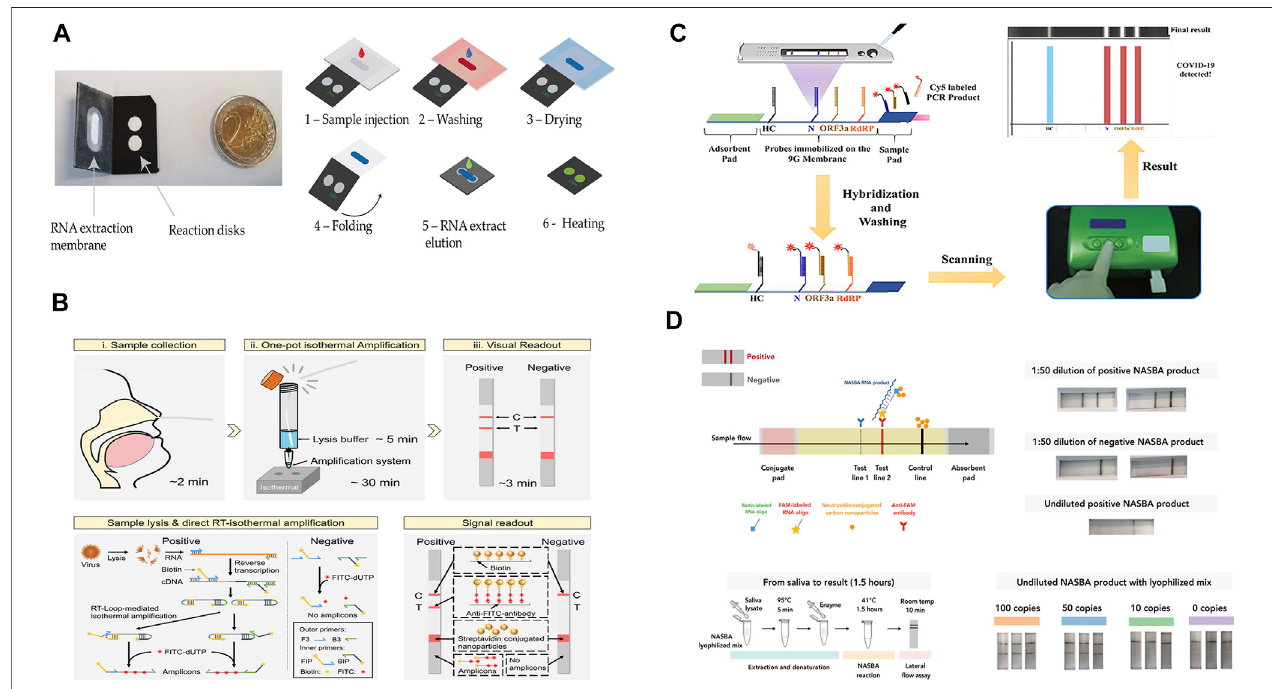
FIGURE4|(A) paper-based μ PADintegratedwithRT-LAMPampli fi cation.Adaptedwithpermissionfrom(Garneretetal.,2021)underCreativeCommonslicense; (B) lateral fl ow combined with one-pot RT-LAMP ampli fi cation. Adapted with permission from (Zhang et al., 2021), copyright American Chemical Society 2021; (C) multiplex detection of SARS-CoV-2 genome. Adapted with permission from (Yu et al., 2020) copyright American Chemical Society 2020; (D) two-stage detection and multiplexed sequencing technique. Adapted with permission from (Wu et al., 2021) under Creative Commons license.